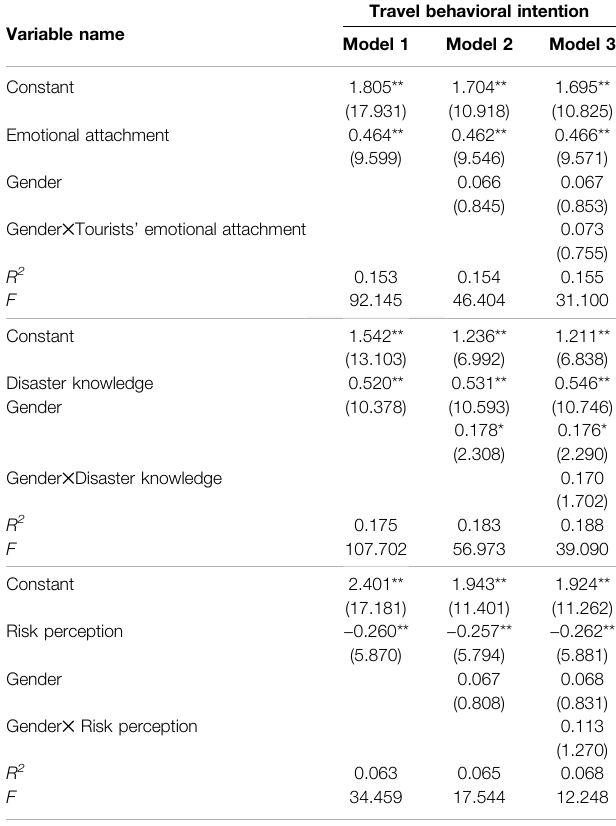
TABLE 7 | Analysis of the moderating effect of gender.